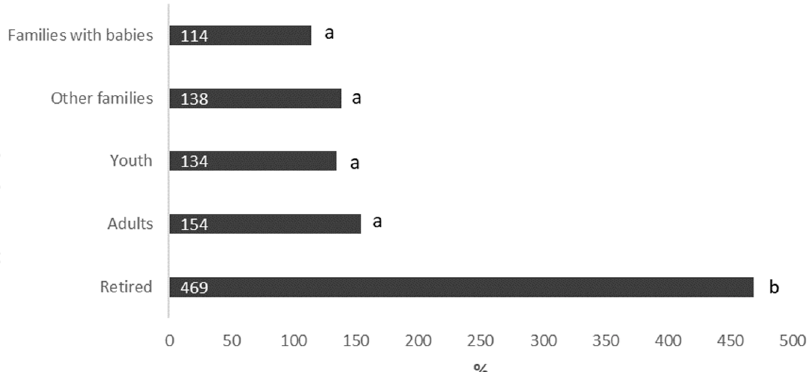
Figure 2. Relative increment in total purchases of fish, seafood, and fish products in Spain, from 2019 to 2020, during the period March to June, according to the type of loyalty card holder in Spain. 11% of loyalty card holders are unclassified. Different letters represent statistically significant differences ( p <